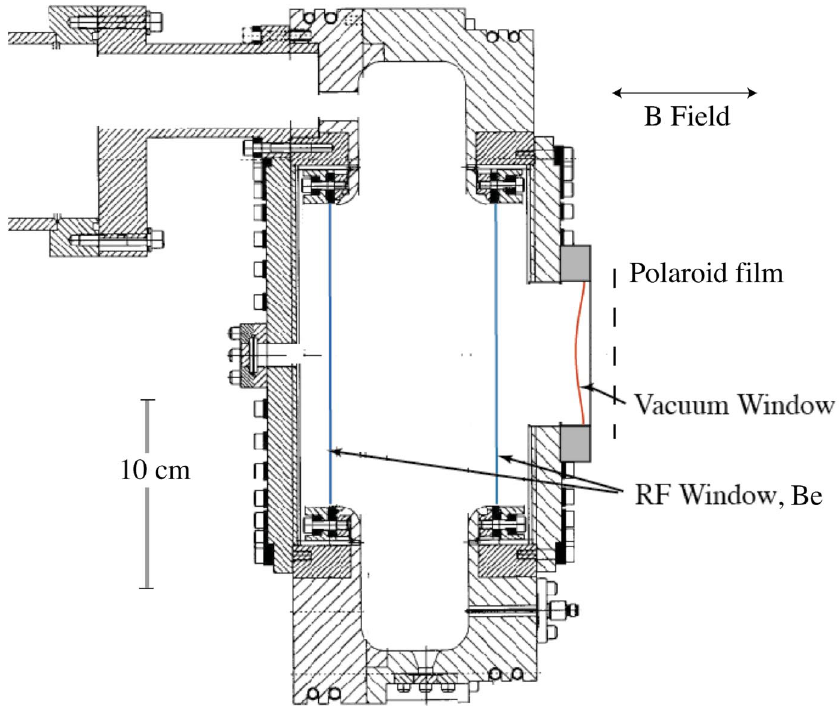
FIG. 1. (Color) The pillbox cavity showing 0.254 mm Be rf windows and 0.2 mm Ti vacuum